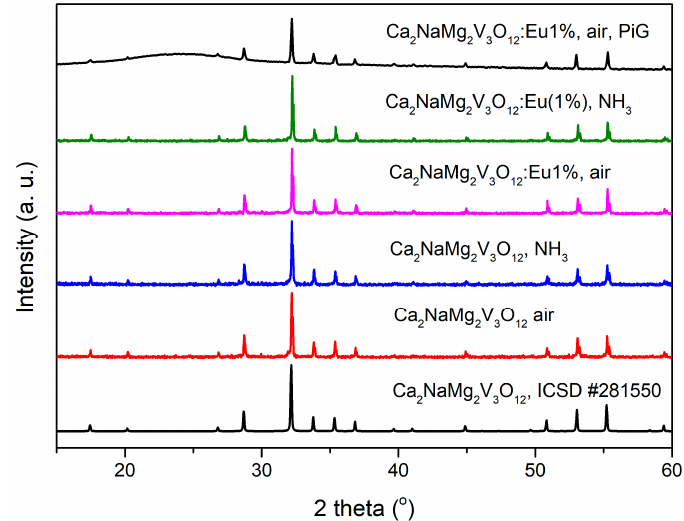
Figure 1. X-ray di ff raction (XRD) patterns of undoped Ca 2 NaMg 2 V 3 O 12 and doped with 1% of Eu 3 + obtained in di ff erent atmospheres and as phosphor-in-glass (PiG) along with the standard card of Ca 2 NaMg 2 V 3 O 12 (ICSD no. 281550).